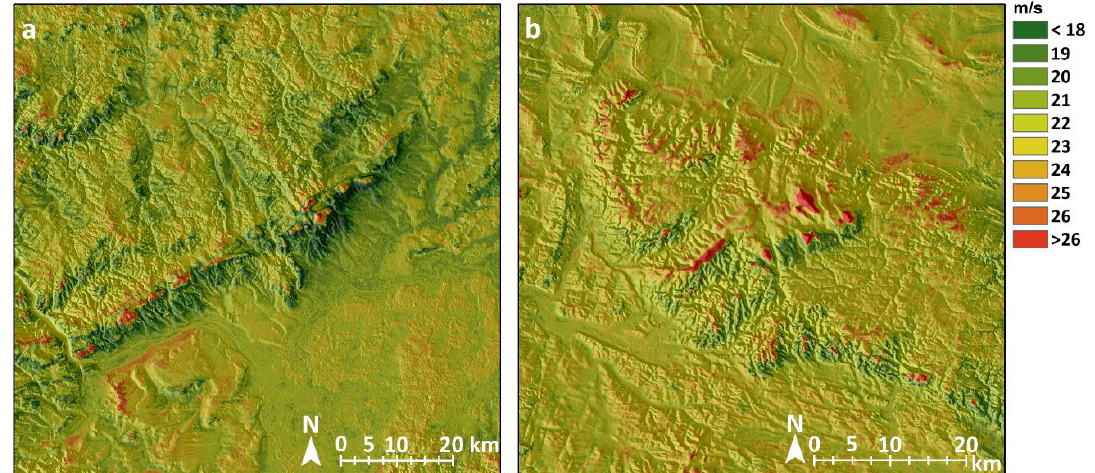
Figure 4. Map extracts of median gust speed ( (cid:102) GS ) in the regions ( a ) north of the city of Frankfurt and